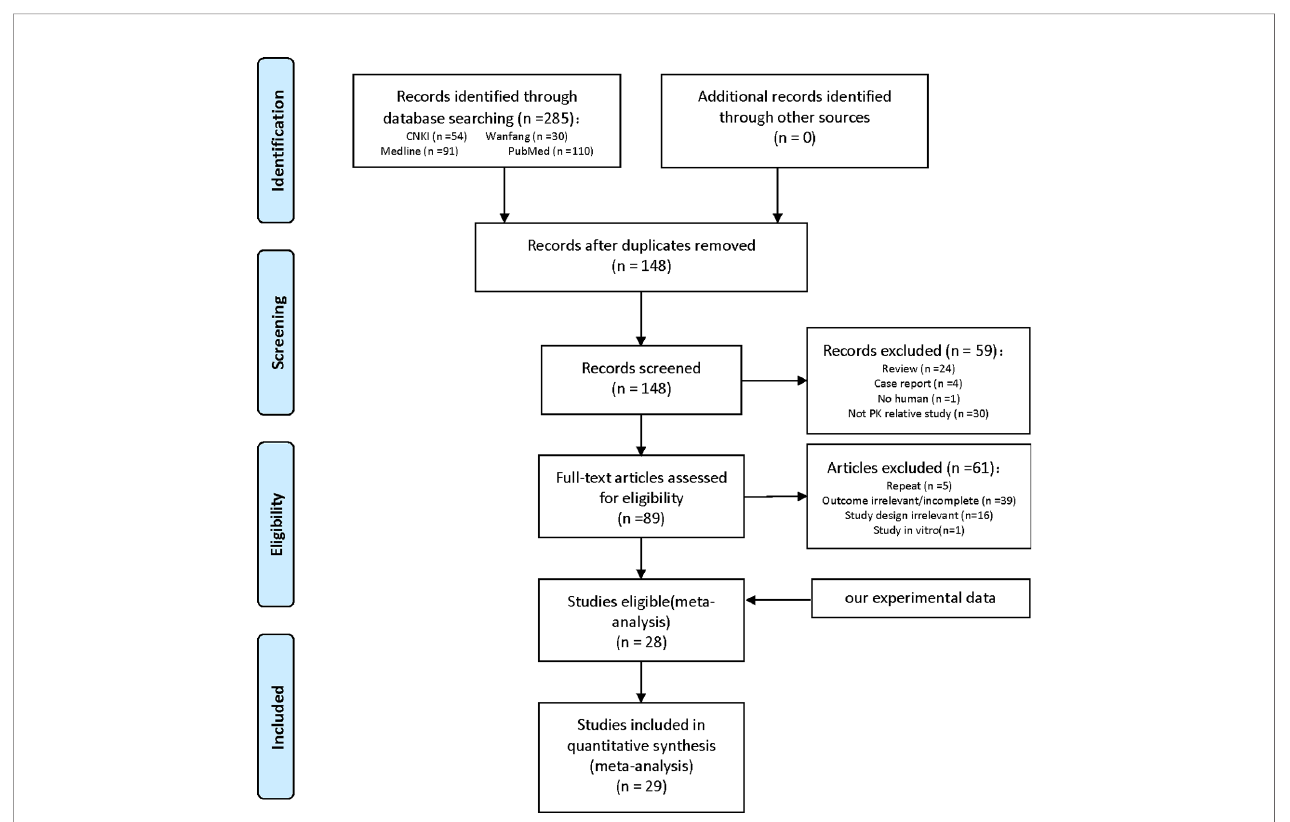
FIGURE 2 | PRISMA fl ow chart of the study selection.